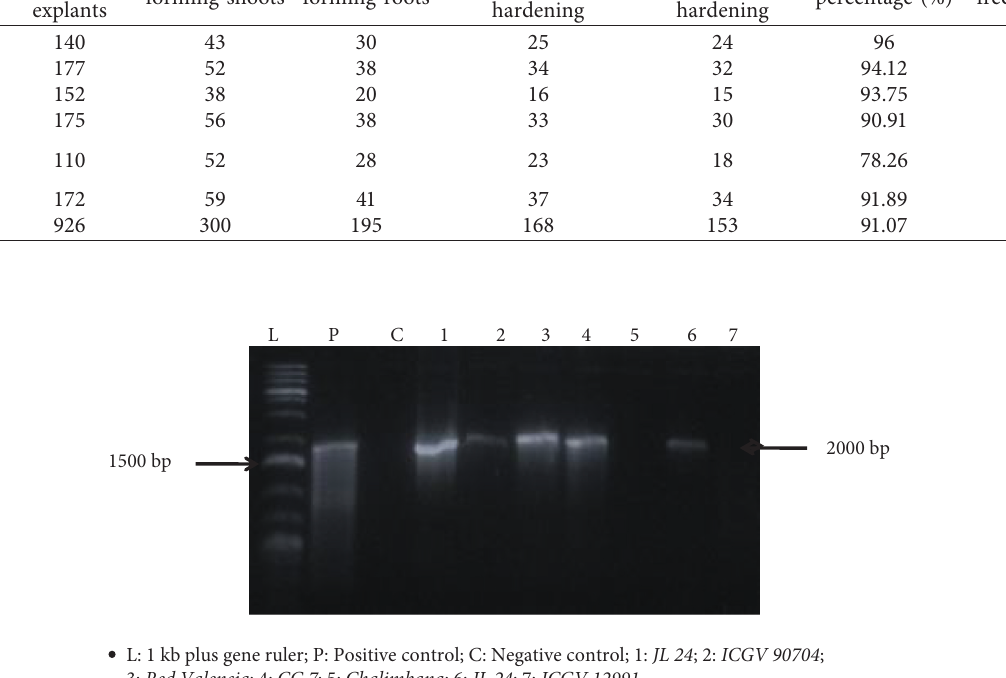
Figure 3: PCR analysis of putative T0 groundnut plants using IPT gene-specific primers. L: 1 kb plus gene ruler; P: positive control;